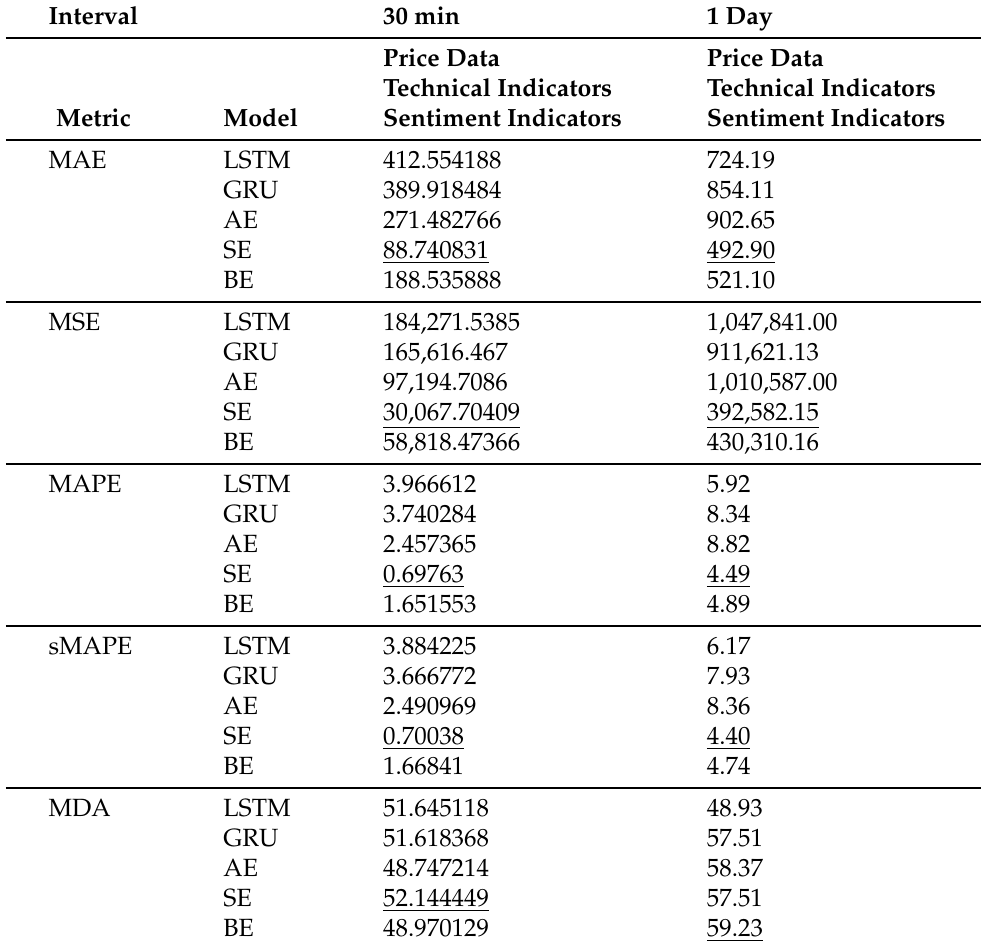
Table 6. Comparison of the metrics obtained by the models.